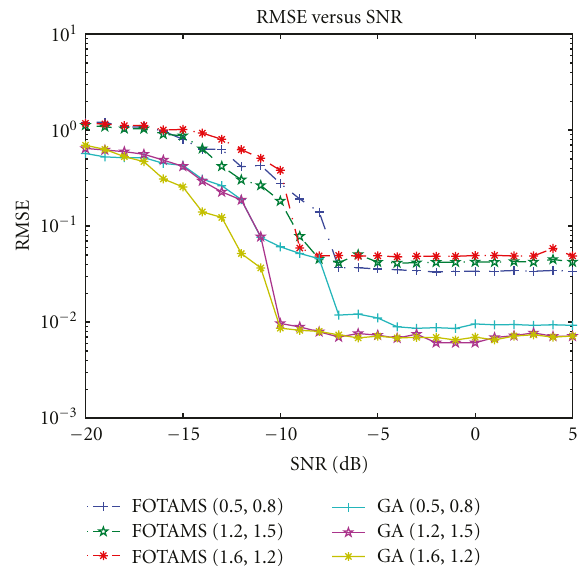
Figure 5: RMSEs of frequency estimation versus the SNR, e ( m , n ) is i.i.d white exponential noise, the data size is 50 × 50.